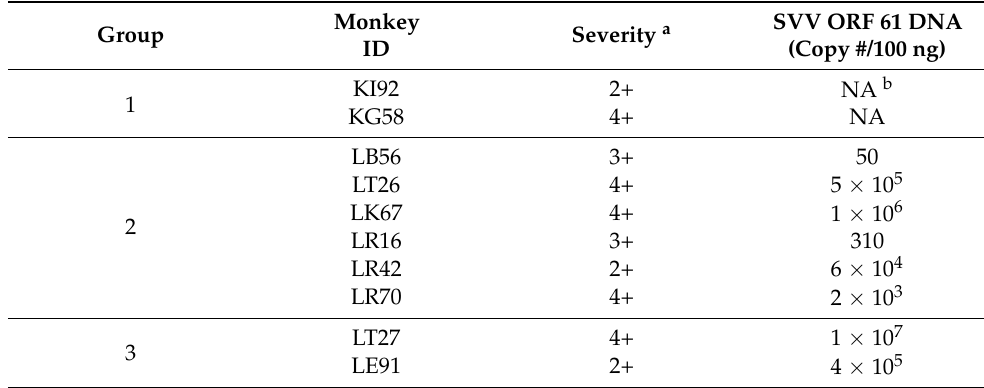
Table 2. Severity of varicella (7–9 dpi) rash and detection of SVV DNA in skin